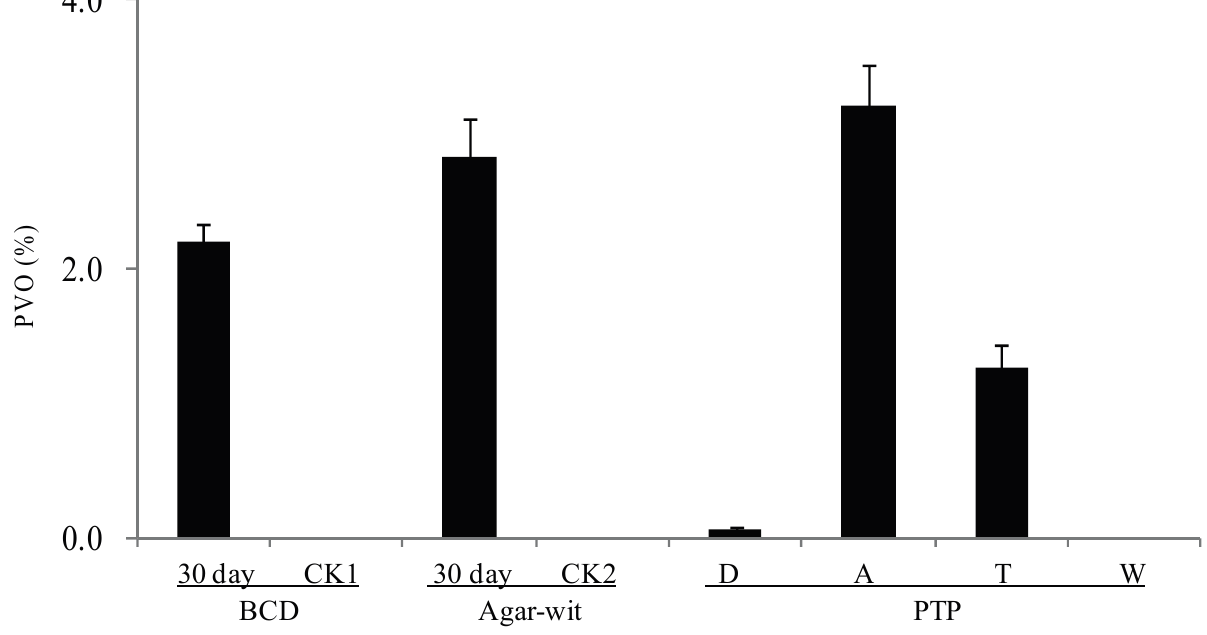
Figure 4. Wound-induced vessel occlusions detected (in the decay, agarwood, transition, and healthy zones) at least 10 months after the PTP treatment and 30 days after the Agar-wit and BCD treatments. No tyloses were detected in any vessel lumen of an unwounded control sample. PVO means the percentage of vessels with occlusions per mm 2 . Error bars represent the SE, n = 5. The wounded wood obtained by the PTP method was divided into four zones, the decay (D), agarwood (A), transition (T), and white (W) zones. The samples obtained from the untreated healthy trees and the trees treated by the Agar-wit with ddH 2 O not inducers are referred to as CK1 and CK2,